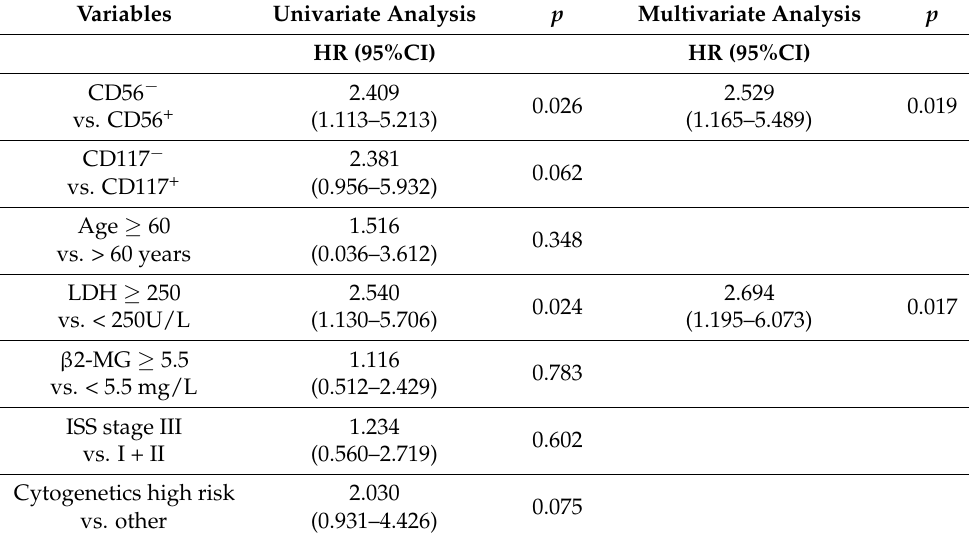
Table 5. Univariate and multivariate COX regression analyses for